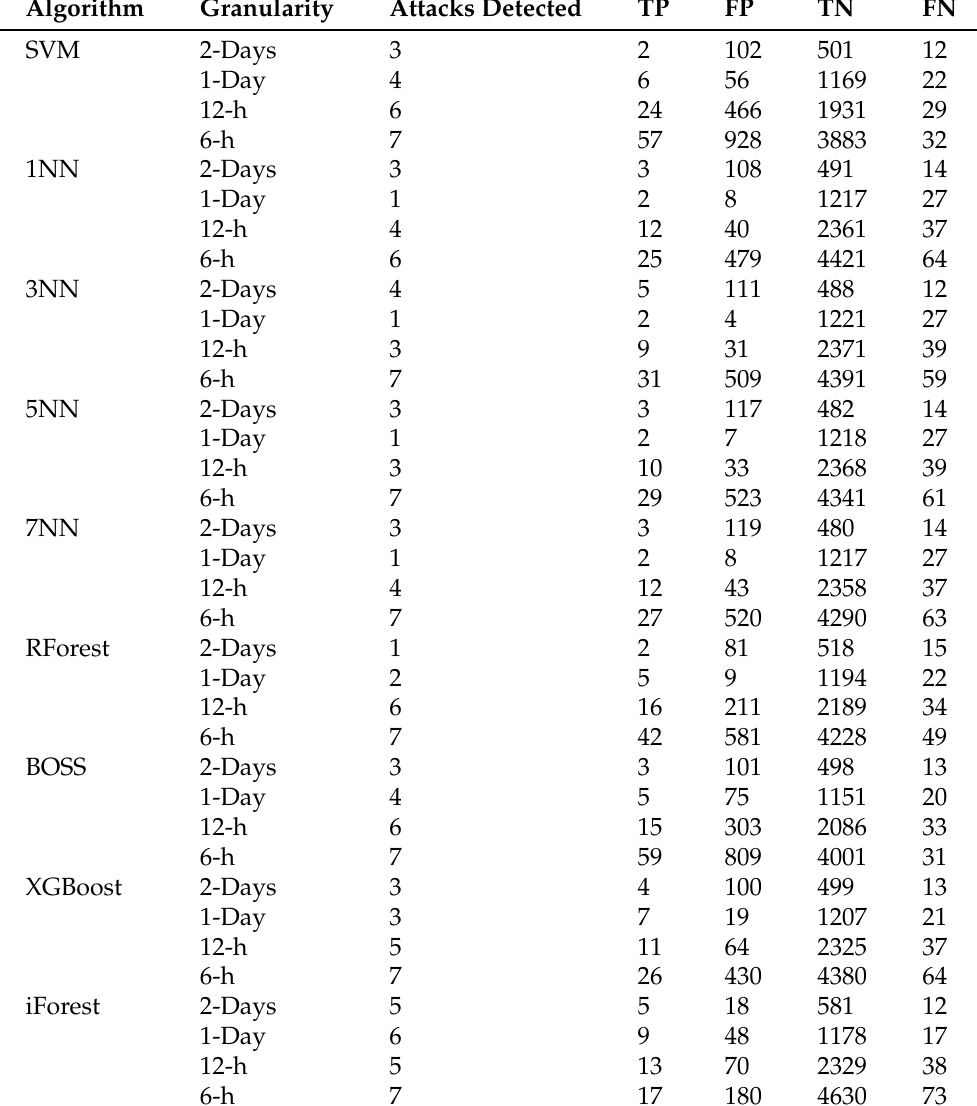
Table 3. Performance Evaluation of our results for both stages at different